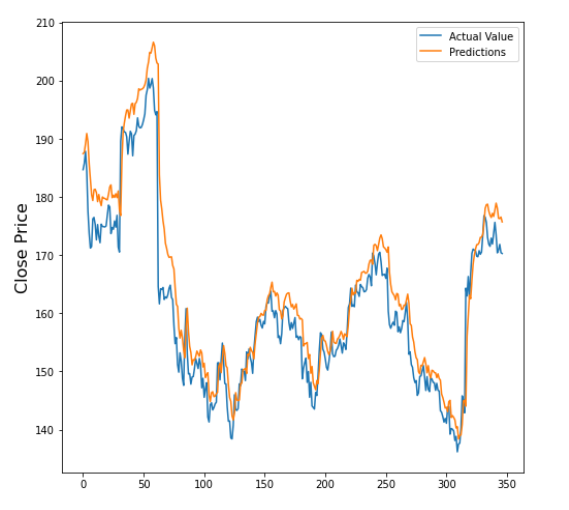
Figure 12. Prediction of Close price using CNN